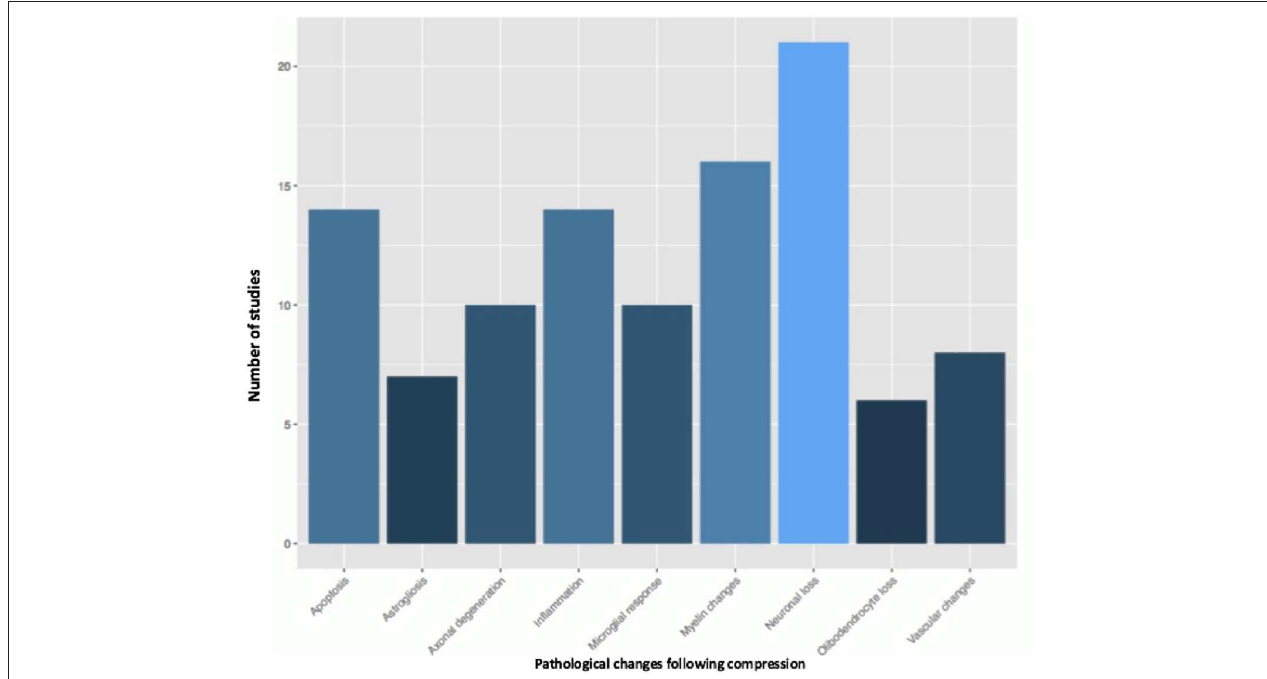
FIGURE 2 | Pathological changes found in the chronically compressed cervical spinal cord.